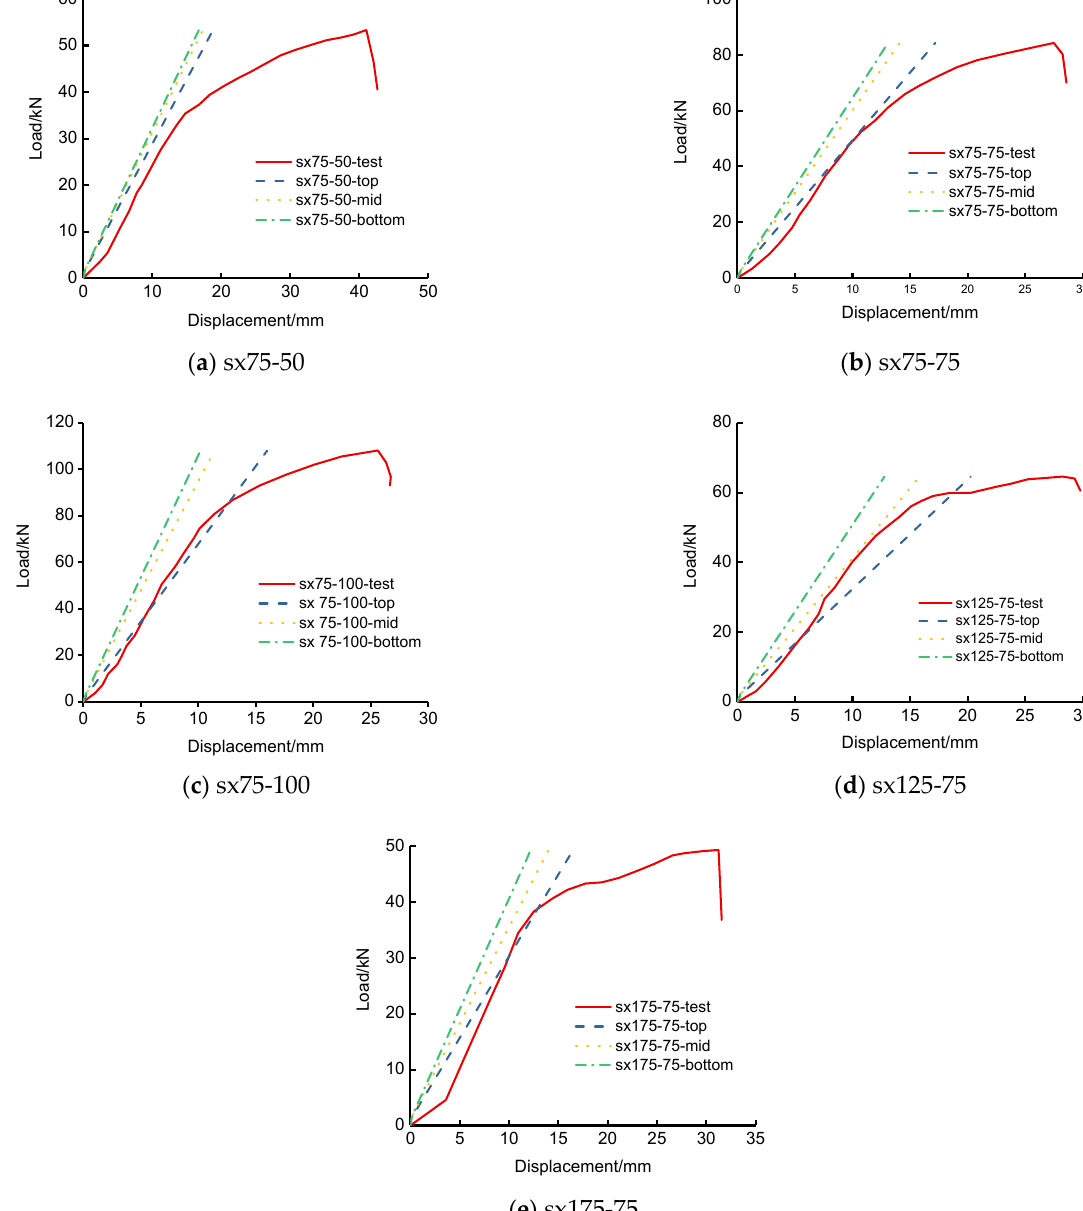
Figure 6. Load-deflection curves under the concentrated load for two-way simply supported SLCPs.